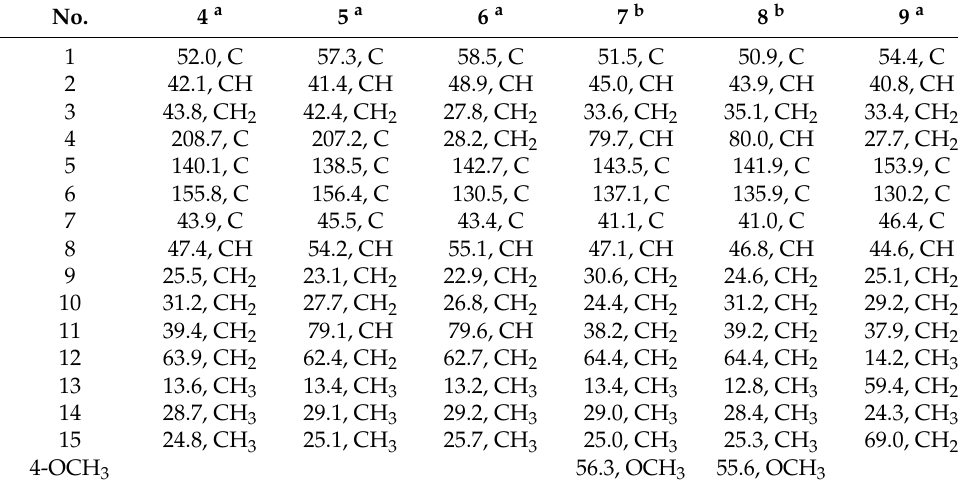
a measured in MeOH- d